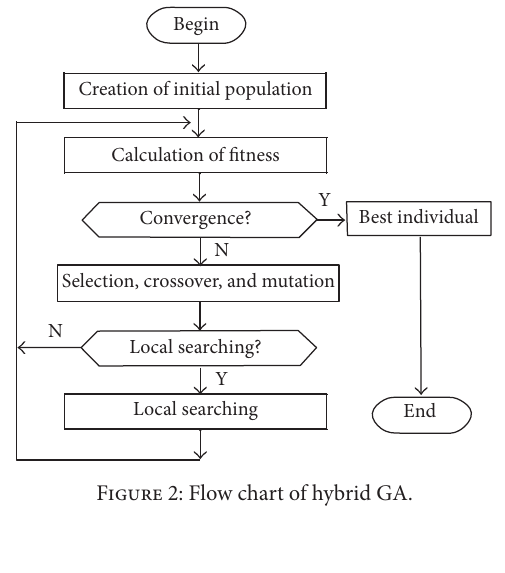
Figure 2: Flow chart of hybrid